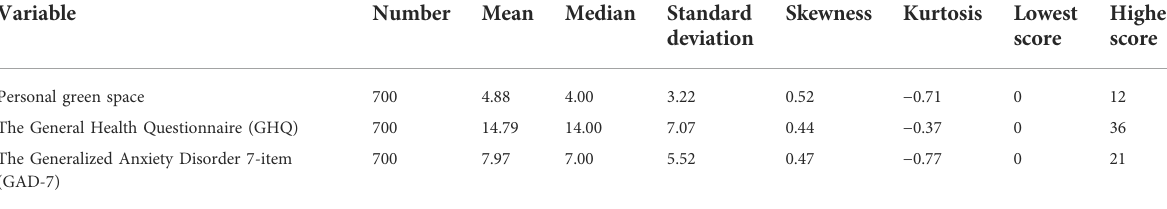
TABLE 4 Indicators of descriptive statistics of research